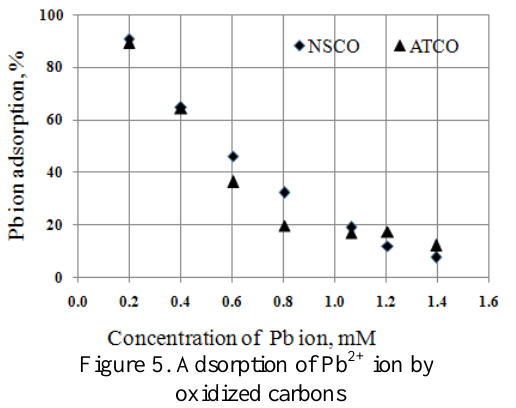
Figure 5. Adsorption of Pb 2+ ion by oxidized